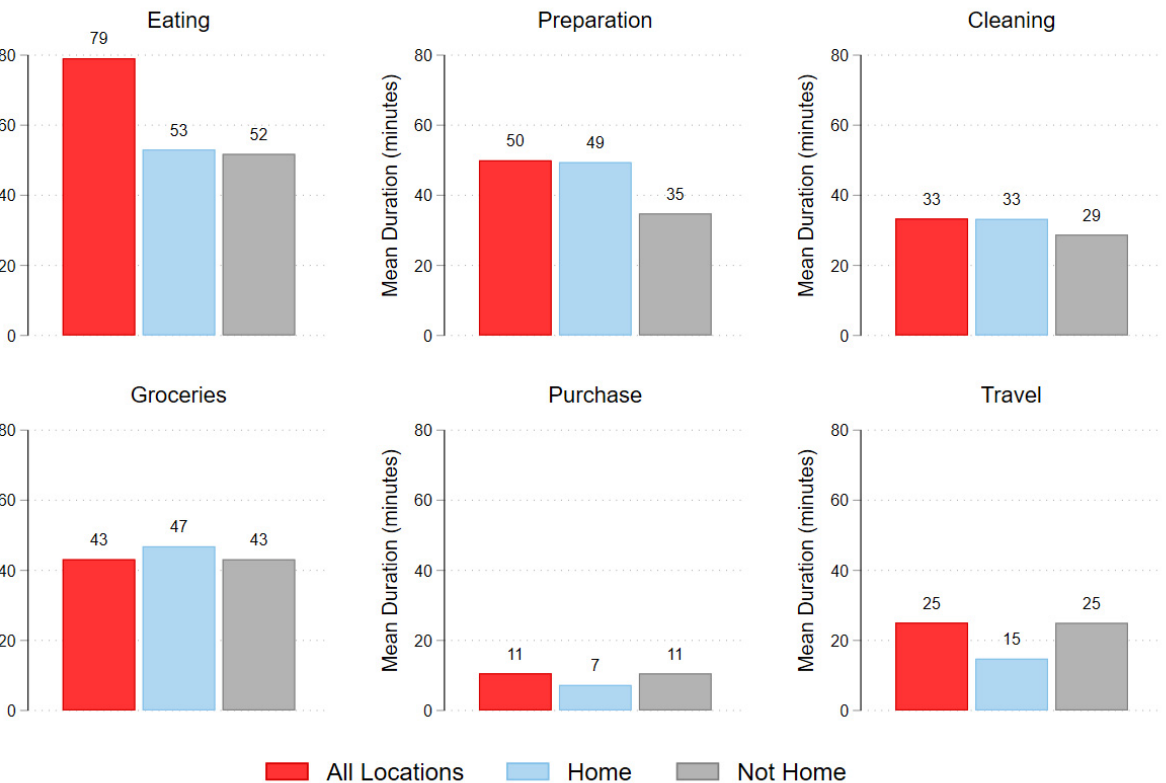
Figure 1. Mean duration (minutes) for food-related activities.